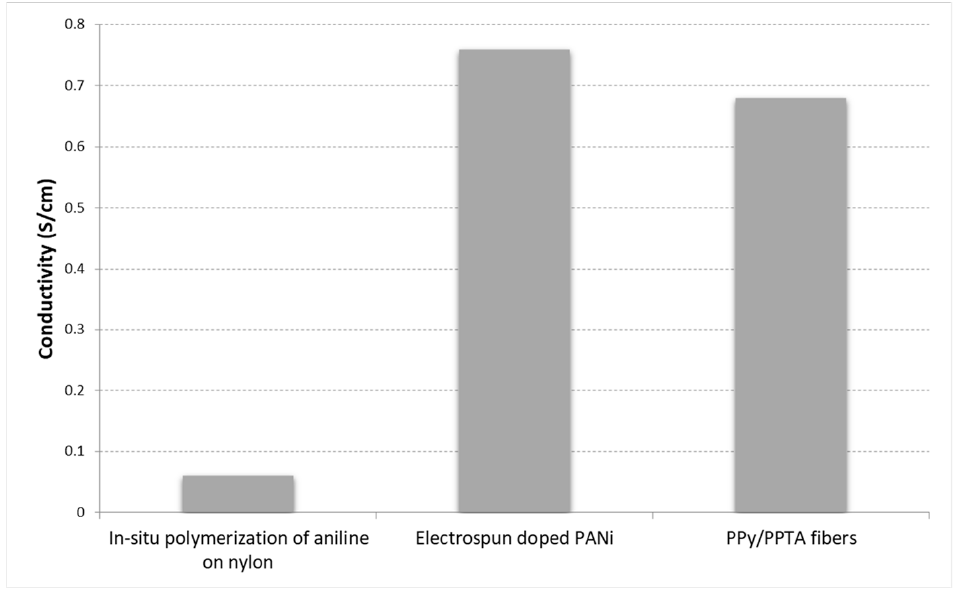
Figure 8. Example conductivity levels of PANi and PPy based materials according to the literature.